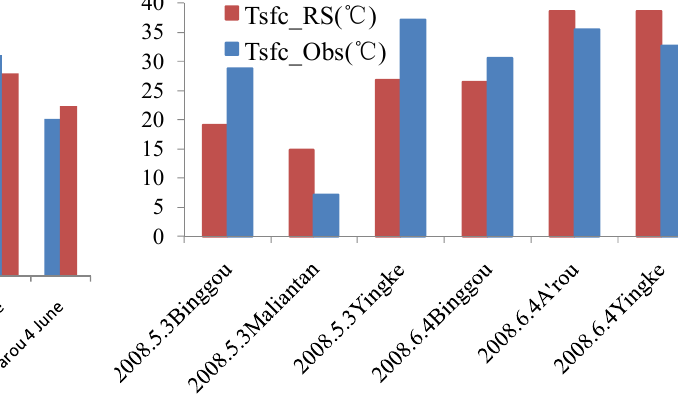
Fig. 6. Validation of the derived land surface temperature against ground measurements over the WATER stations.